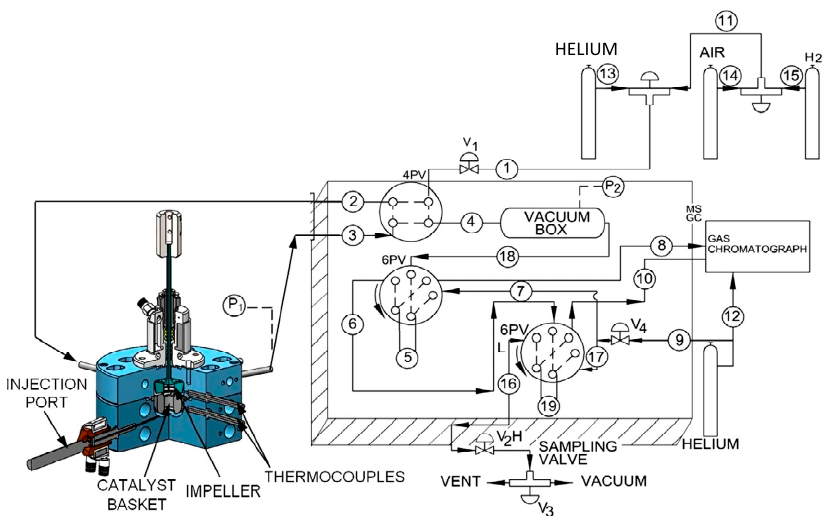
Figure 14. Schematic diagram of the CREC riser simulator and its accessories. The 4PV permits (i) the isolation of the reactor for gasification to take place (when lines 2–3 are connected) and (ii) the reactor evacuation (when lines 3–4 are connected). The two 6 PVs allow (i) the loading of sampling obtained in the sample loops 5 and 19 with the lines 18-5-6 and 6-19-16 being connected and (ii) the directing the sample to the capillary and packed bed column of the GC (Gas Chromatograph) system through connections 7-5-8 and 17-19-10, respectively. Adapted from [116].